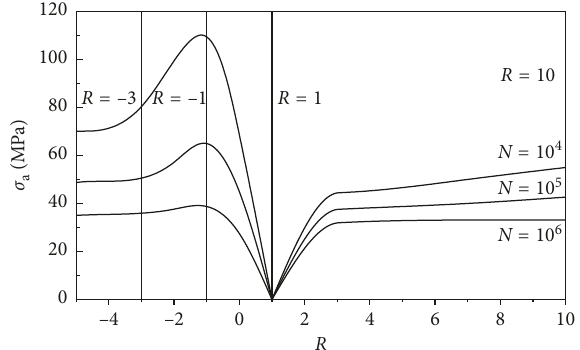
Figure 2: Representation of the PNL CLD model on the R − σ